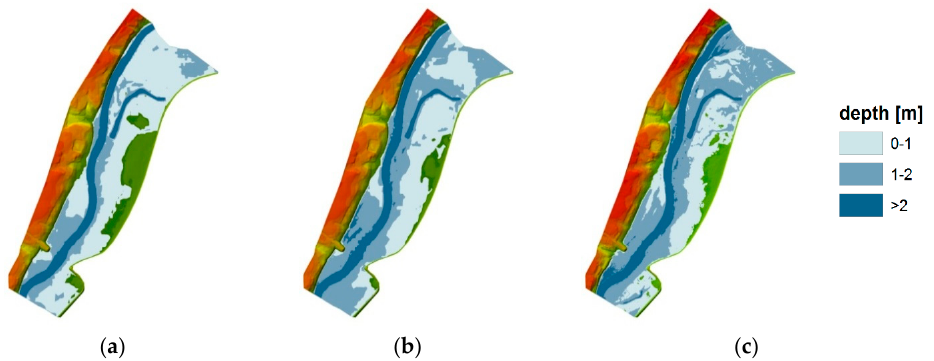
Figure 10. Comparison of the flooded area and inundation depth values for the flow rate equal to 279.1 m 3 ·s − 1 : ( a ) original DEM; ( b ) corrected DEM; and ( c ) reference DEM.